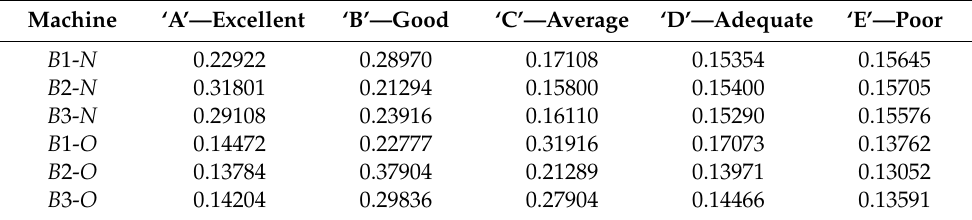
Table 8. Assessment of bulldozer availability by expert’s